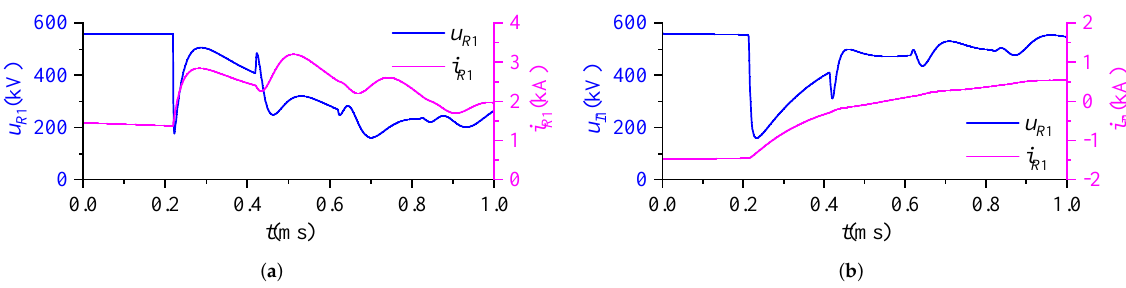
Figure 8. Positive sequence mode VTWs and CTWs of both terminals with internal fault (F1). ( a ) Positive sequence mode VTW and CTW of rectifier side. ( b ) Positive sequence mode VTW and CTW of inverter side.